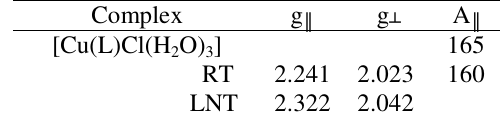
Table 2. Powder Spin-Hamiltonian parameters of Cu(II) complex